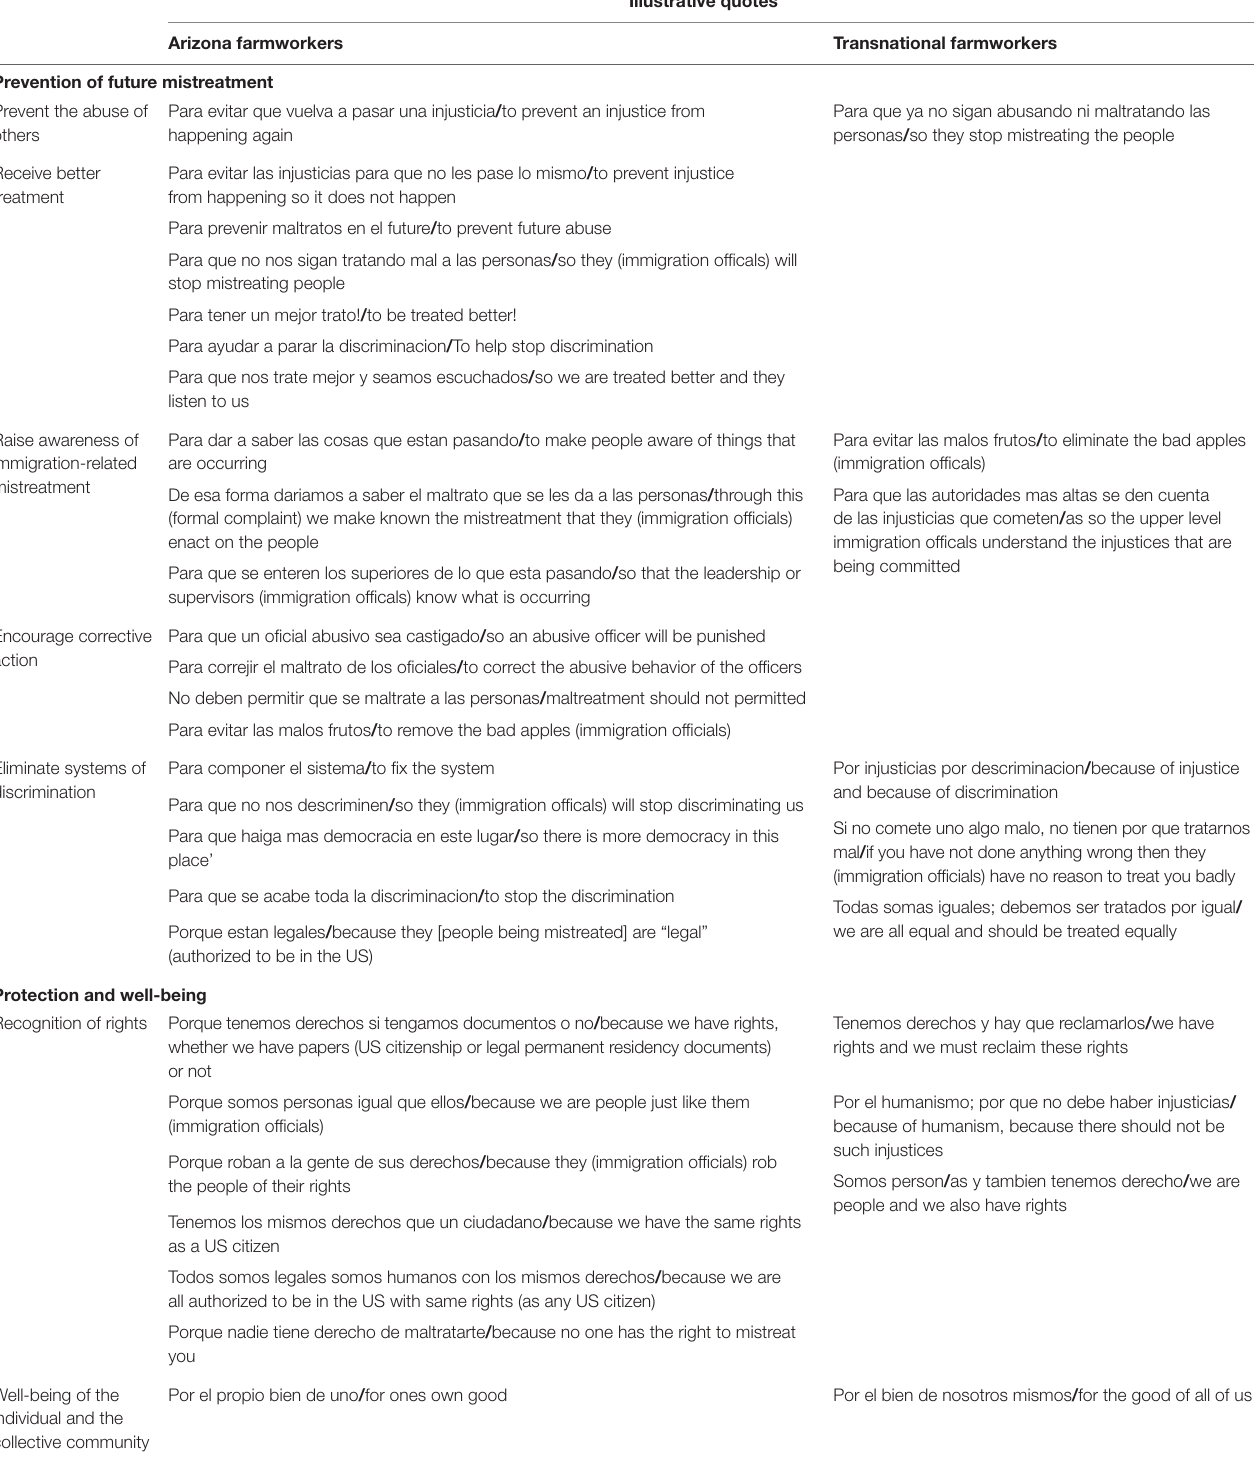
TaBle 3 | summary of reasons to file a formal complaint of immigration-related mistreatment among arizona and transnational farmworkers of Mexican